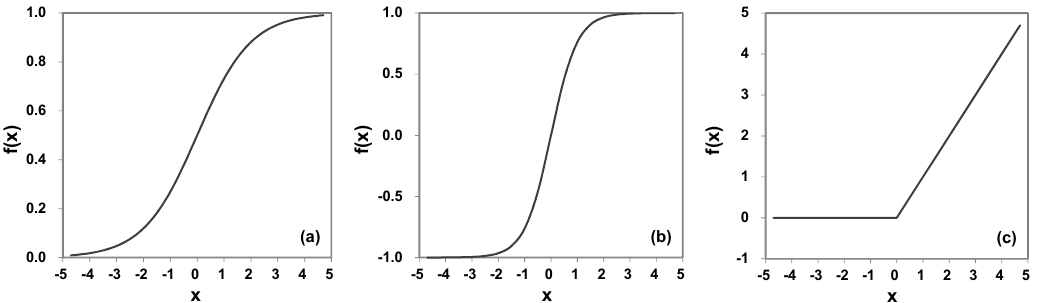
Figure 3. Activation functions in neural networks; ( a ) sigmoid, ( b ) hyperbolic tangent, and ( c ) rectified linear unit (ReLU).